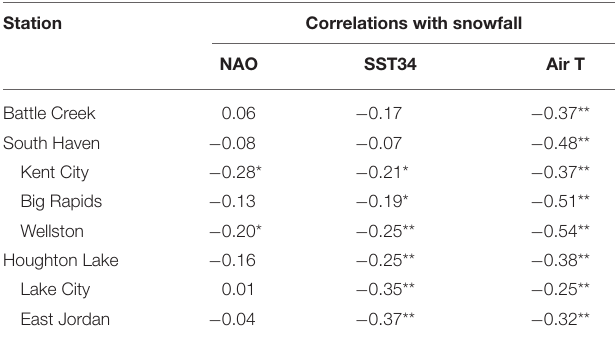
TABLE 2 | Pearson correlation coefficients ( r ) between annual total snowfall and NAO/SST34/Air T for the whole study period (1932–2015) at the stations. Station Correlations with snowfall NAO SST34 Air T